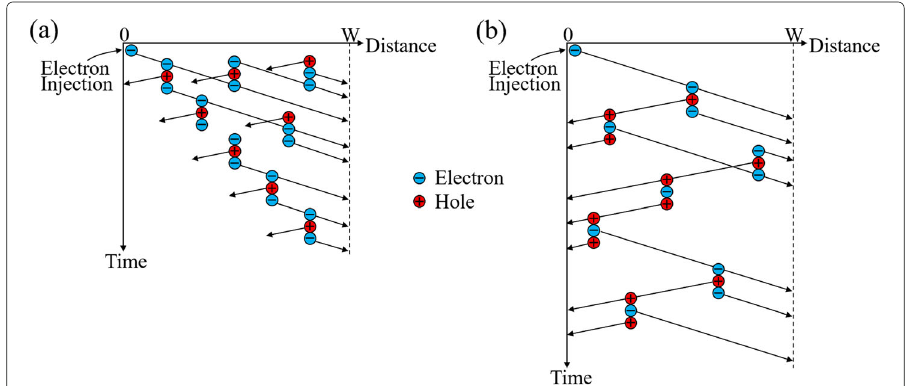
Fig. 2 Schematics of the avalanche process for the impact ionization coefficient ratio of a k =0 ( β =0) and b k =1 ( β = α ). k = β/α where α and β are electron and hole ionization coefficients